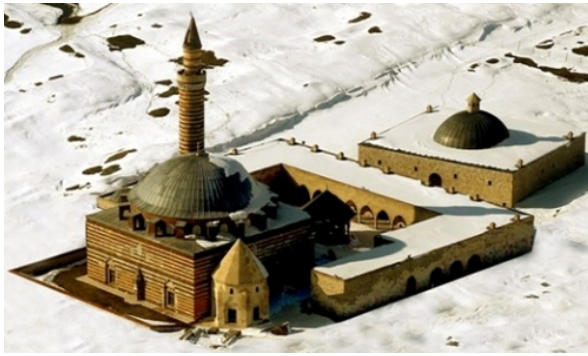
Figure 1. Undamaged view of the Hüsrev Pasha Mosque and social